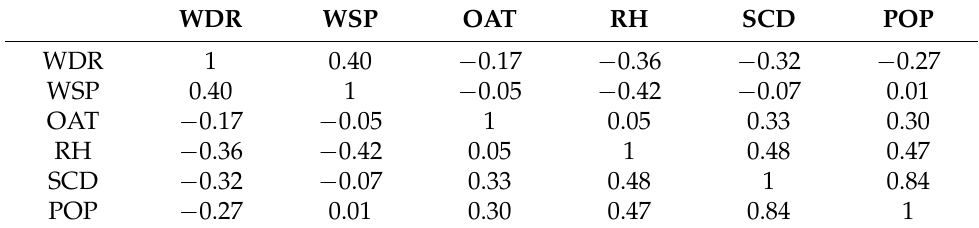
Figure 3. Visualization of Table 3. Table 3. Correlation